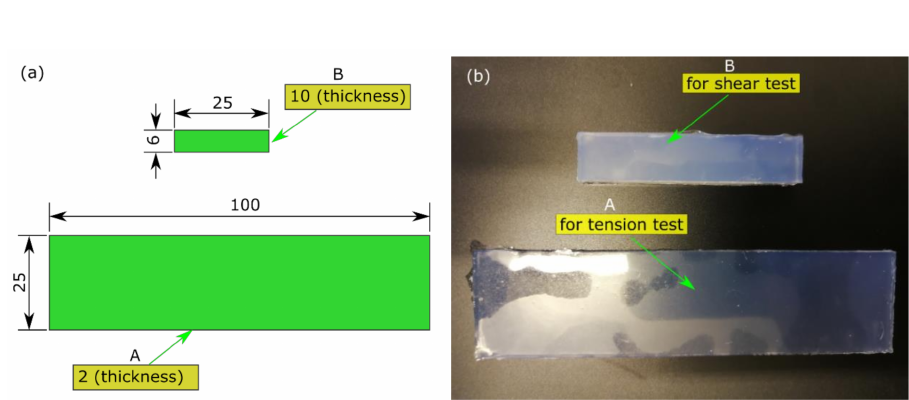
Figure 1. Testing specimens for characterisation: ( a ) dimensions (unit: mm); ( b ) moulded